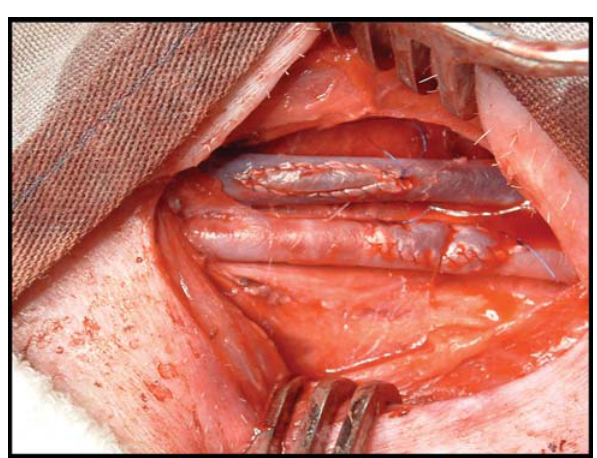
FIGURE 1 - femoral artery patch angioplasty using sugar cane biopolymer membrane. In the same figure it is possible to see the femoral vein with the sugarcane biopolymer